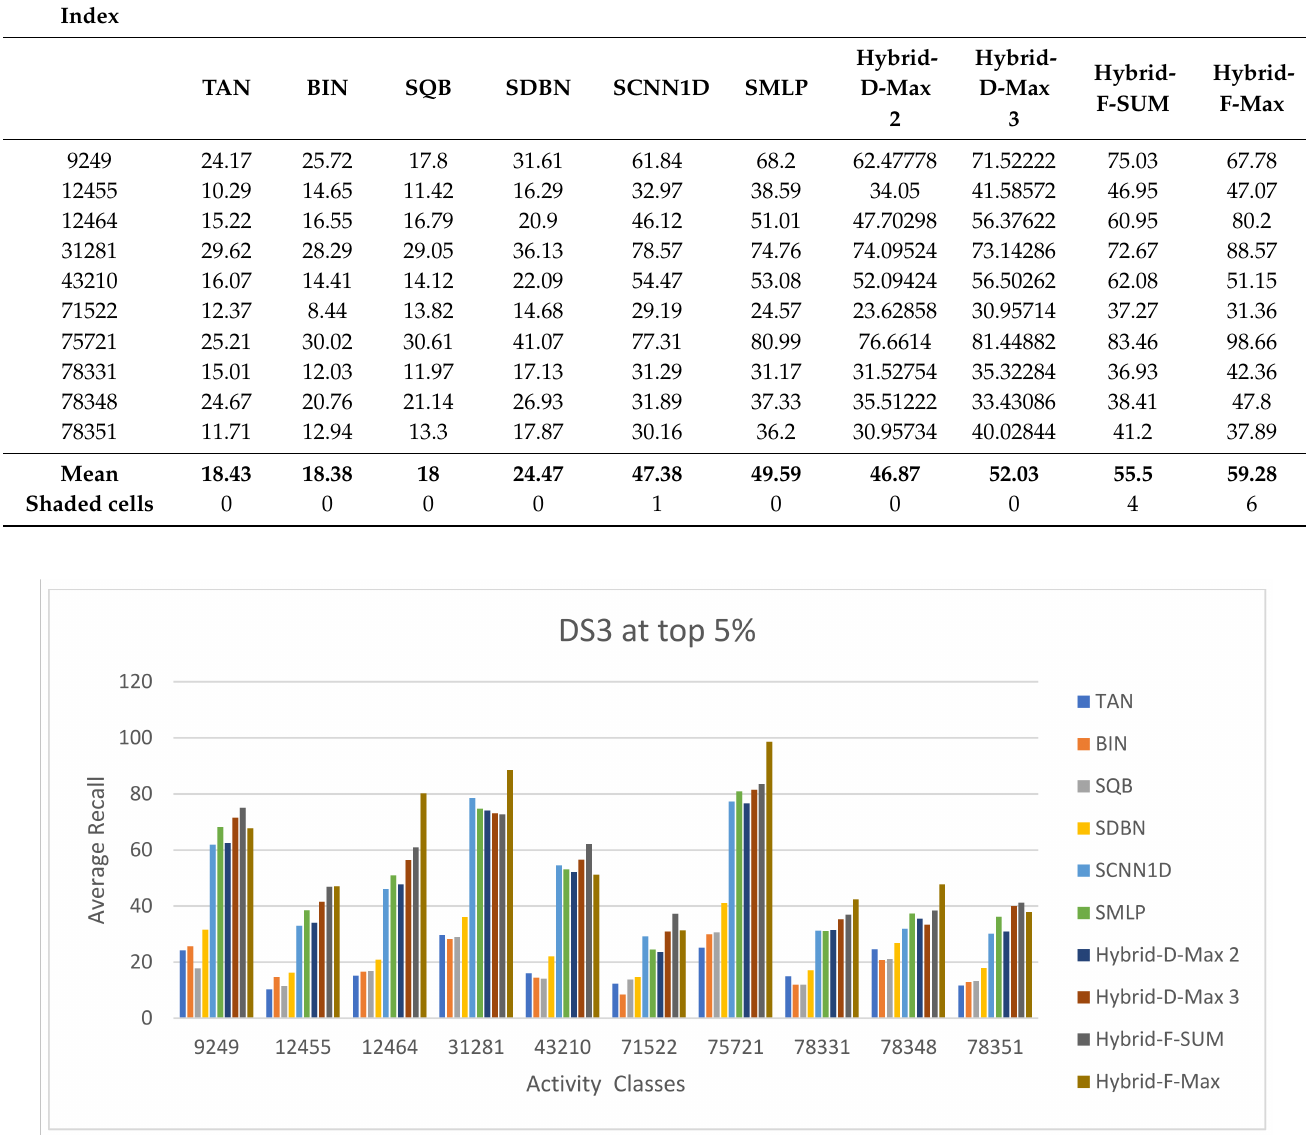
Figure 13. The comparison among methods for the average recall percentage at the top 5% in MDDR-DS3 (structurally